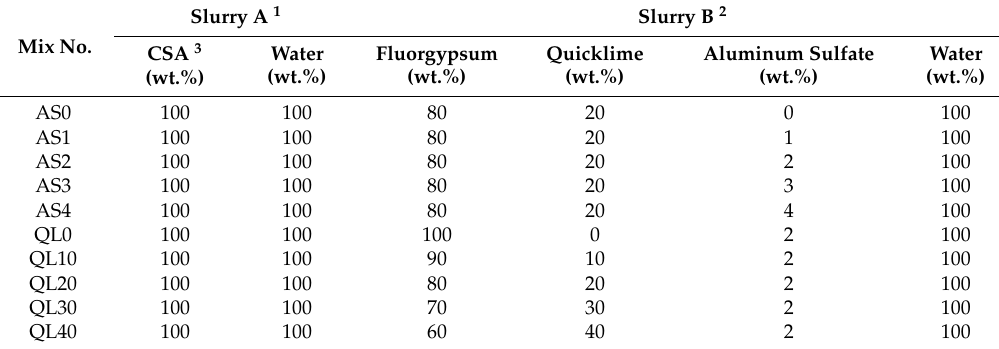
Table 4. Mix proportions of double liquid grouting